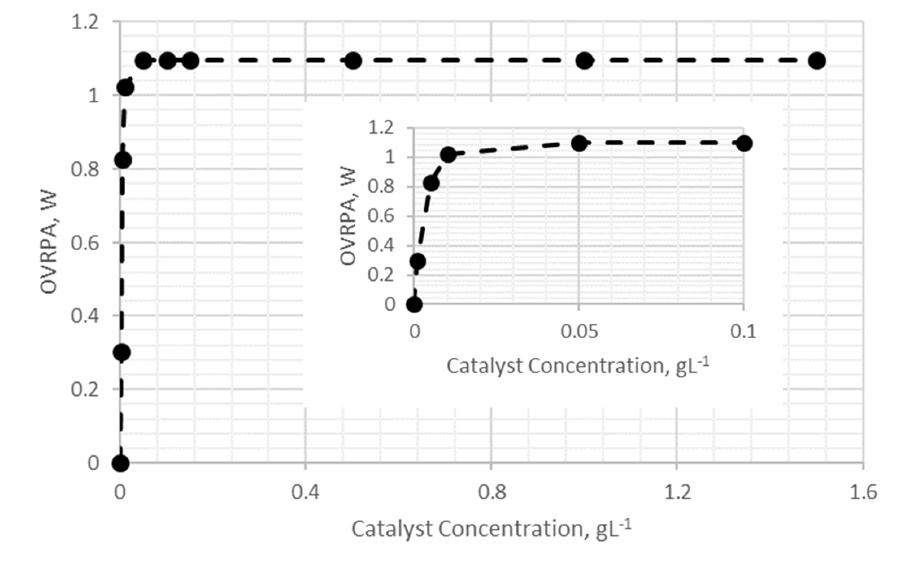
Figure 4. Variation of Overall Volumetric Rate of Photon Absorption (OVRPA) with catalyst con ‐ centration.